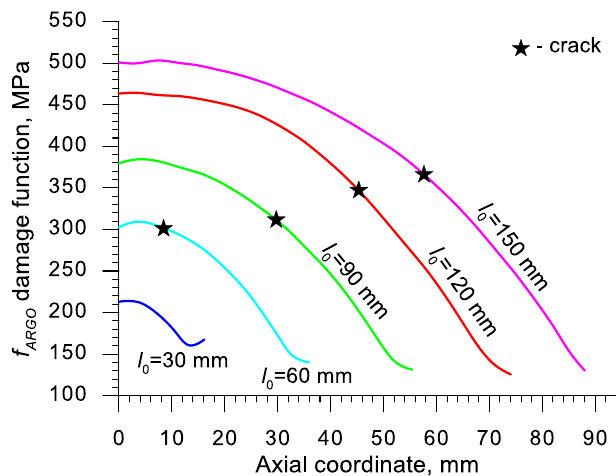
Figure 22. Distributions of the damage function in the axis of a rotationally compressed sample, determined on the basis of the Oyane criterion.